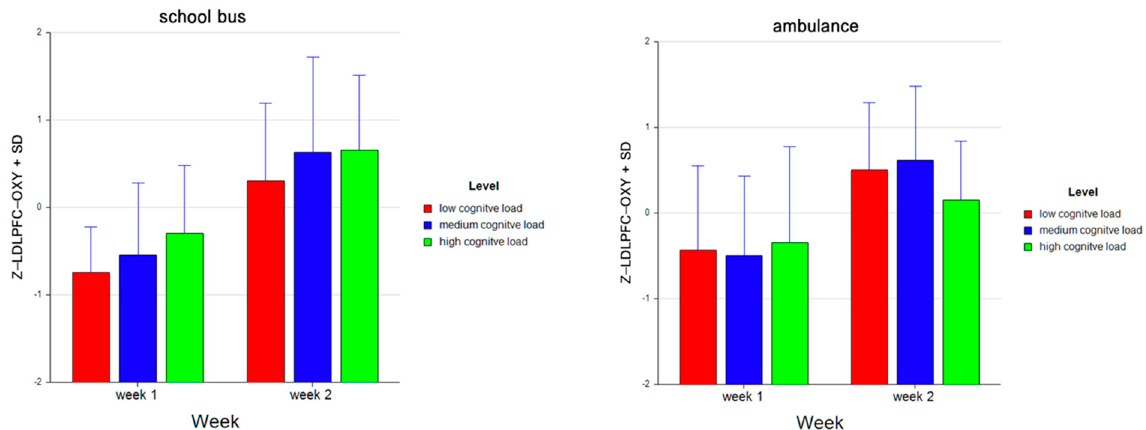
Figure 12. Bar charts represent the average standardized z-scores for oxygenation for left dorsolateral prefrontal cortex (Z-LDLPFC-OXY) and standard deviation (SD) for low cognitive load, medium cognitive load, and high cognitive load tasks for School Bus (left) and Ambulance (right) problem scenarios for Week 1 and Week 2.